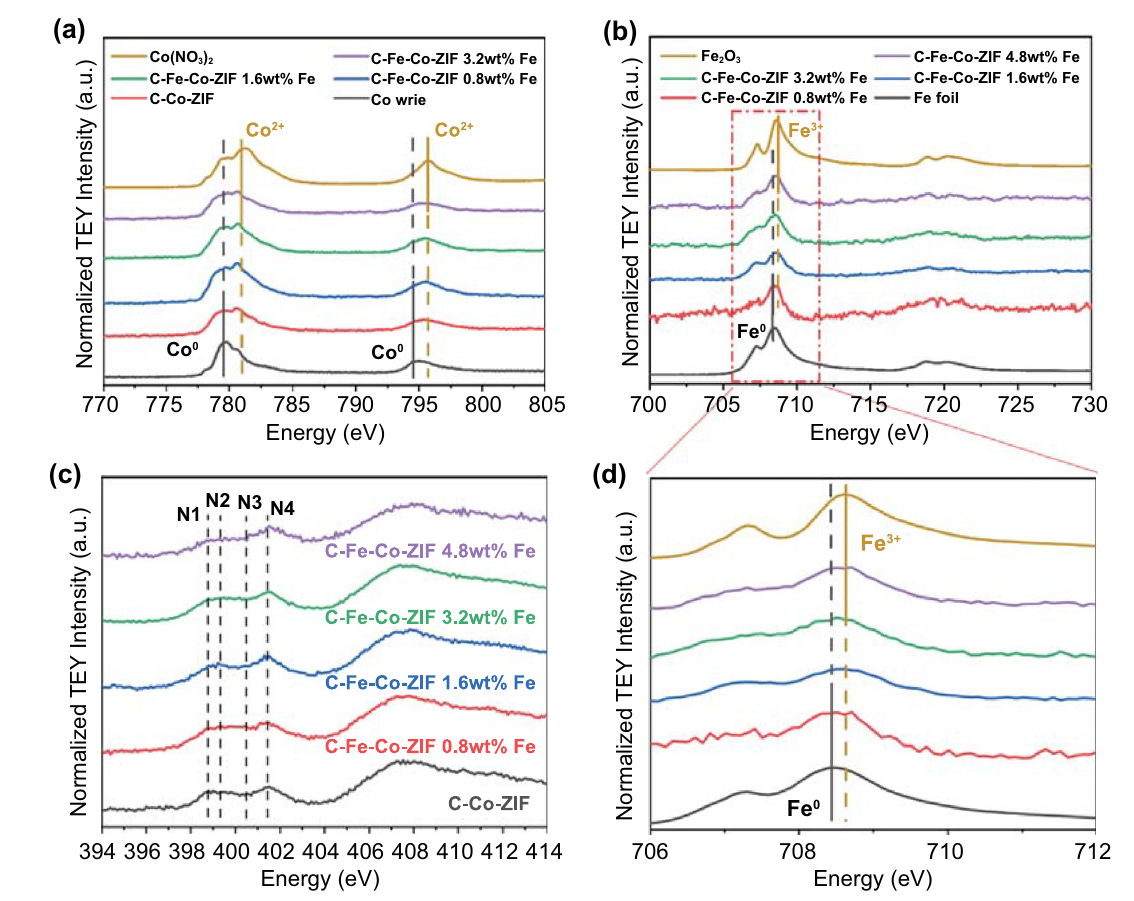
Fig. 3 a Co L-edge XAS. b Fe L-edge XAS. c N K-edge XAS. d Enlarged Fe L-edge XAS of C–Fe–Co–ZIF